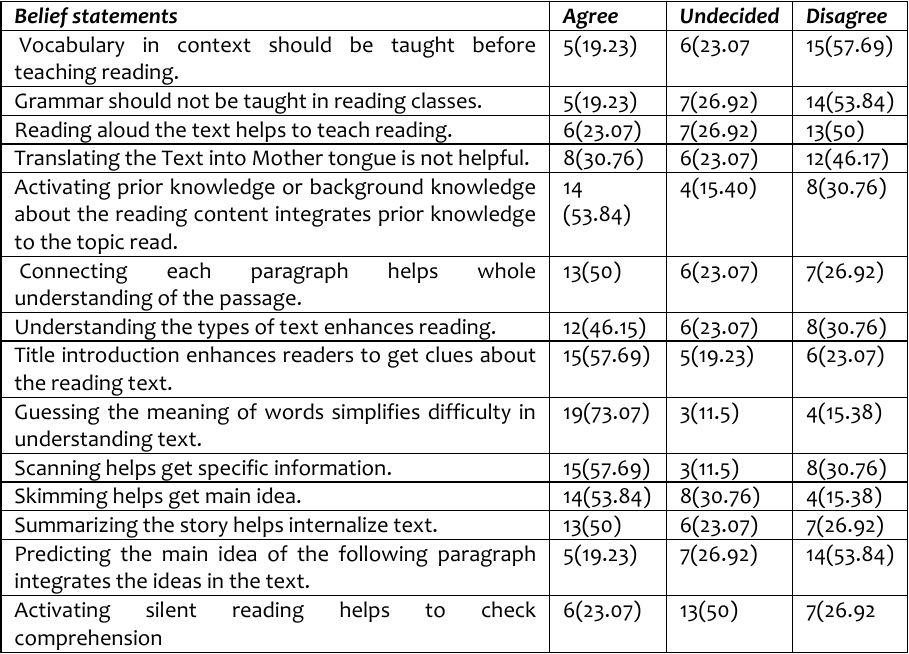
Table 1: Teachers' beliefs about the Importance of Reading